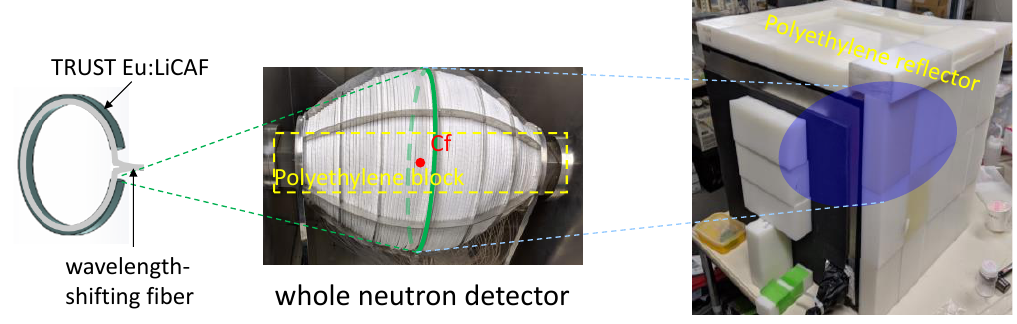
Figure 1. Overview of an experimental system to measure reactor noise in a non-multiplication system with 252 Cf spontaneous fission source.